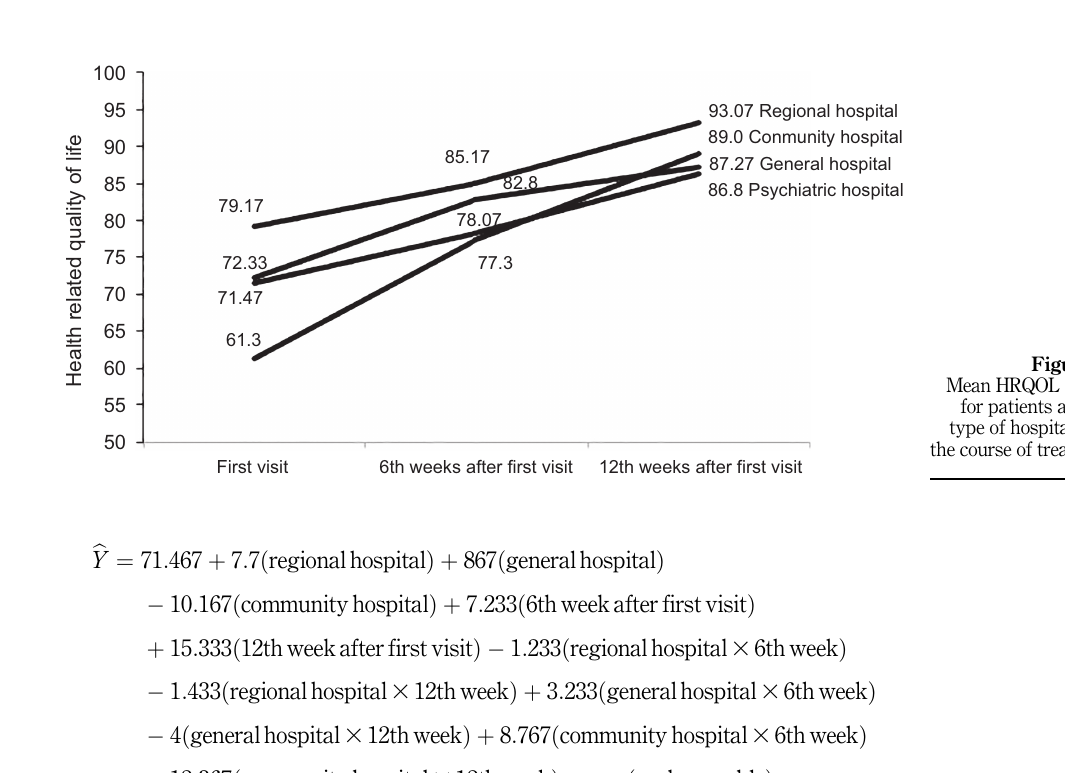
of life in patients with depression